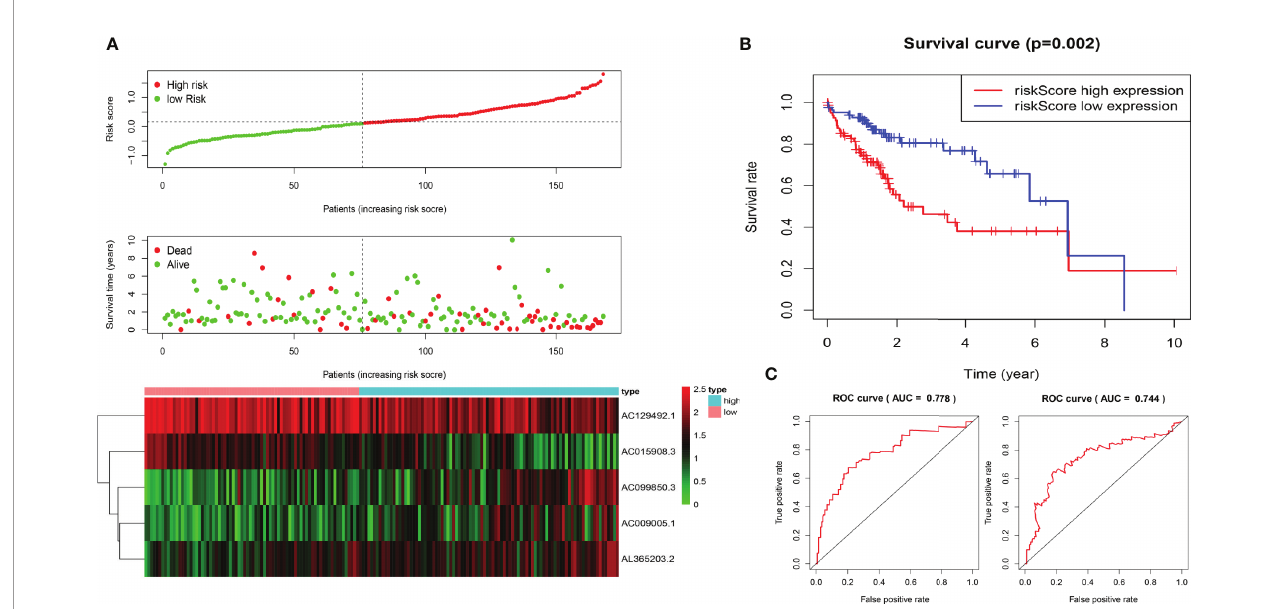
FIGURE 3 | Construction of fi ve-immune-related-gene models from the test dataset. (A) Distribution of high-risk and low-risk groups of patients, scattergram of the patients in the two groups, and heat map of the expression of fi ve lncRNAs in HCC. (B) Kaplan-Meier curves for the OS of patients in the high-risk group and low- risk group in the test dataset. (C) AUC of time-dependent receiver operating characteristic (ROC) curves veri fi ed the prognostic performance of the risk score in the test dataset, and the results showed that the AUC of the model was 0.778 at one year, 0.744 at three